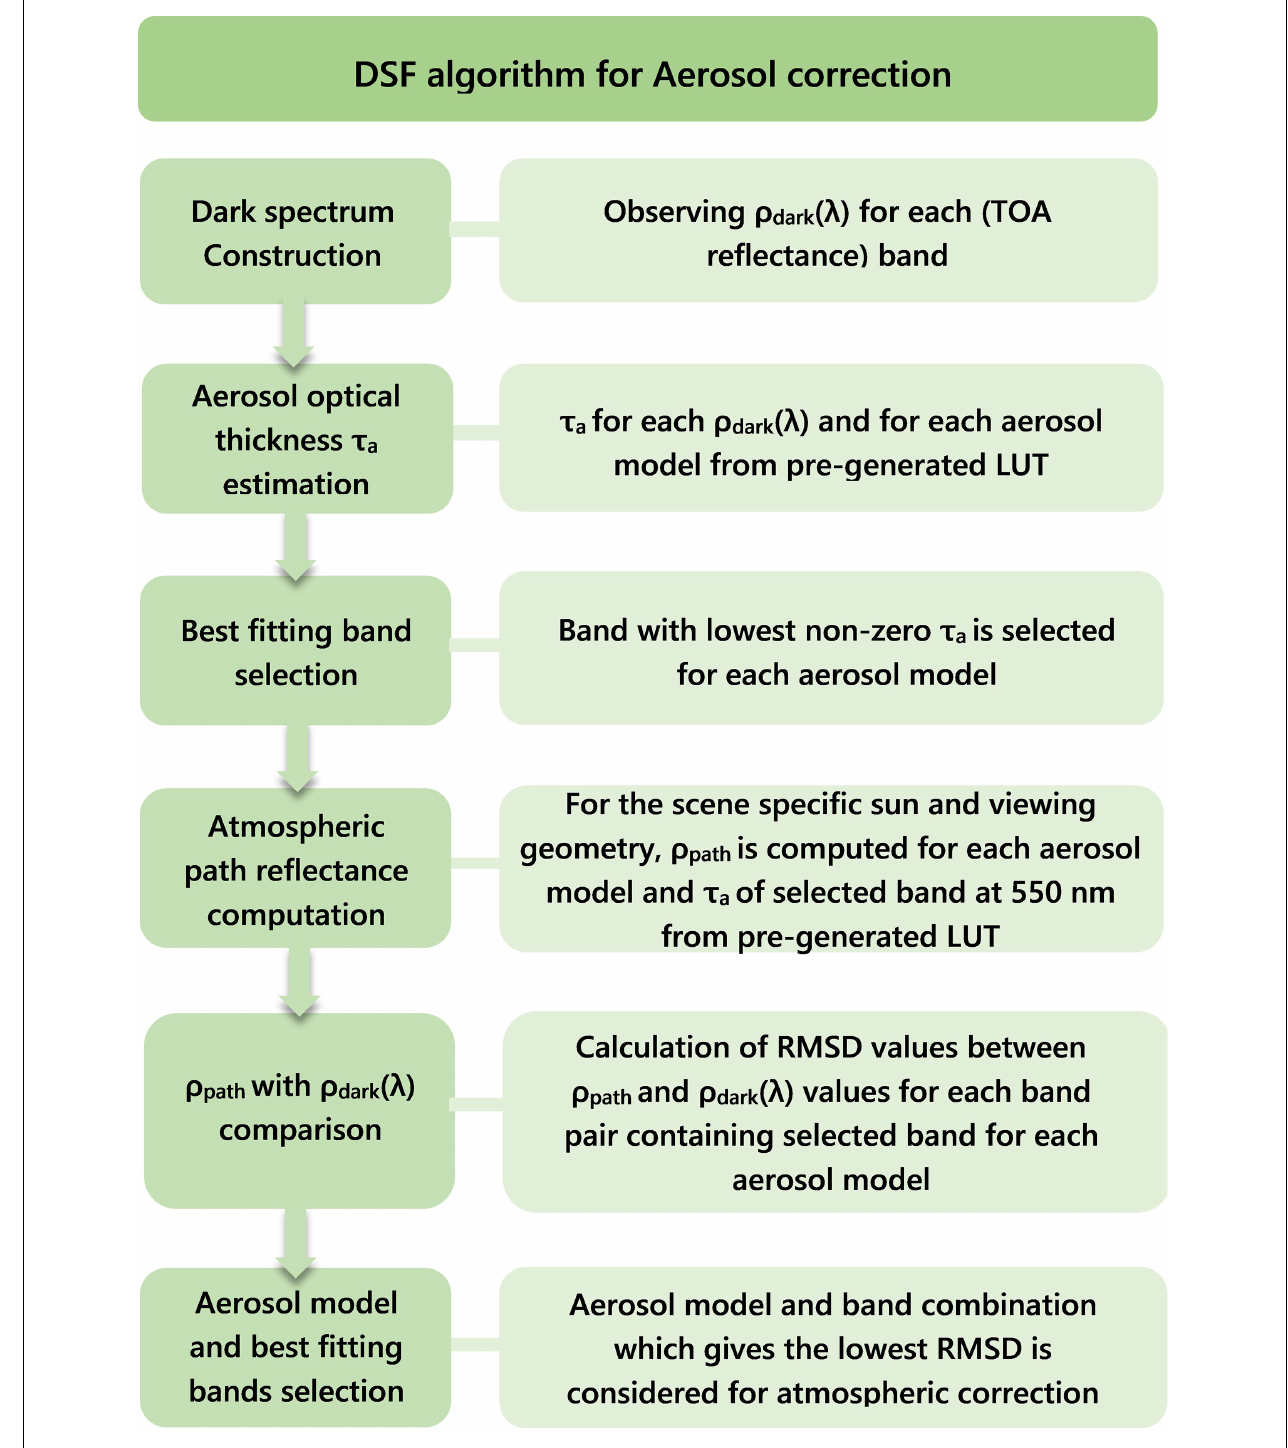
FIGURE 2 | Flow chart representing aerosol correction procedure in DSF algorithm.